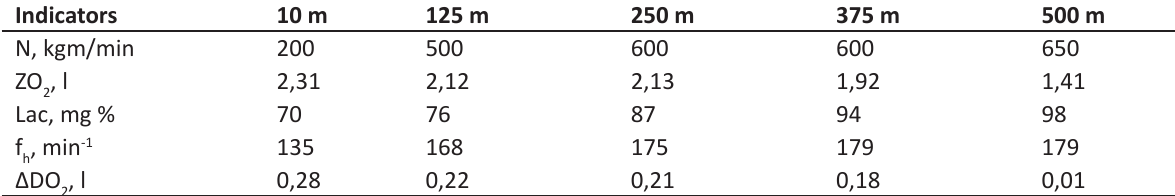
Legend: the same as in table 2. Table 5. Bio-energetic indicators of athletes, when fulfilling two minutes’ loads on row ergo-meter (regime D ) Indicators